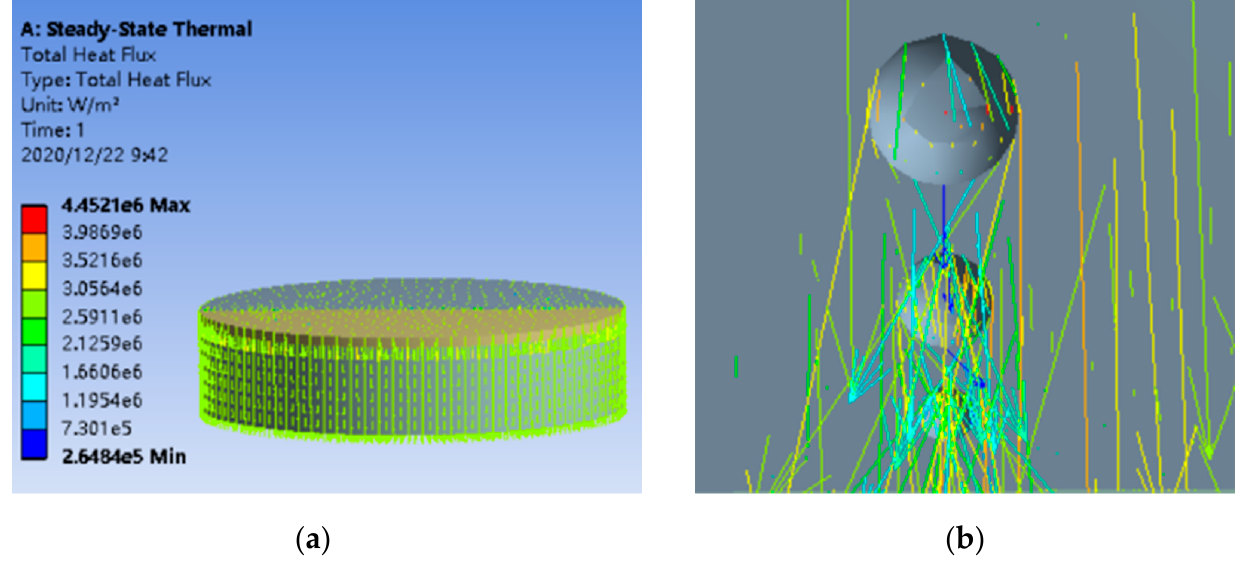
Figure 8. Heat flux distribution cloud: ( a ) whole; ( b ) pores.